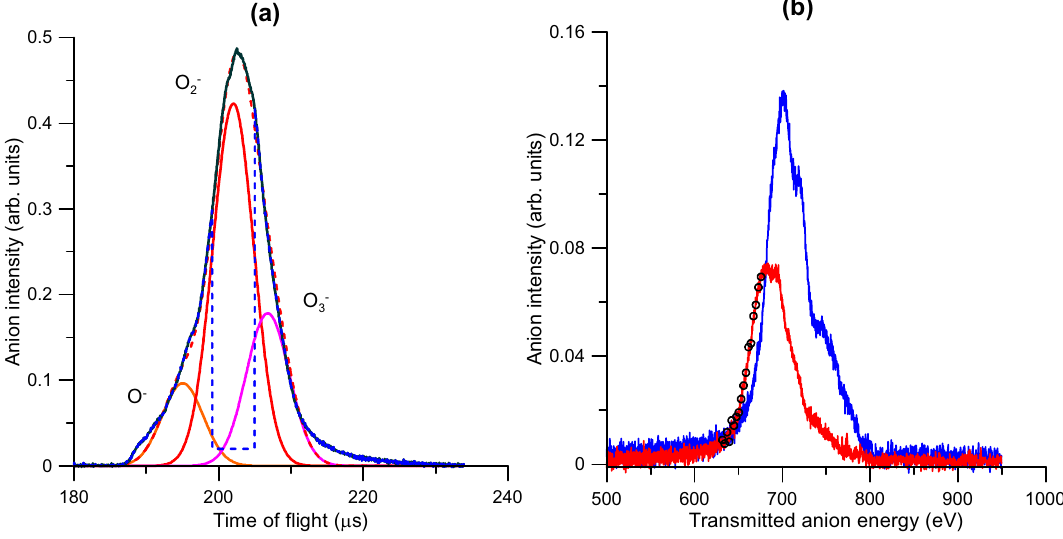
Figure 2. ( a ) Time of flight mass spectra of the primary anion beam: ( ― ) O − , ( ― ) O 2 − , ( ― ) O 3 − , (–-) fraction of the beam removed by the extraction pulse (see text for details). ( b ) Energy spectrum of the transmitted anion intensity for ( ― ) no target molecules in the gas cell, ( ― ) 1.3 mTorr of benzene in the scattering chamber, (o) representative points for which the energy loss of the transmitted O 2 − anions is higher than 24.4 eV (above the double ionization energy